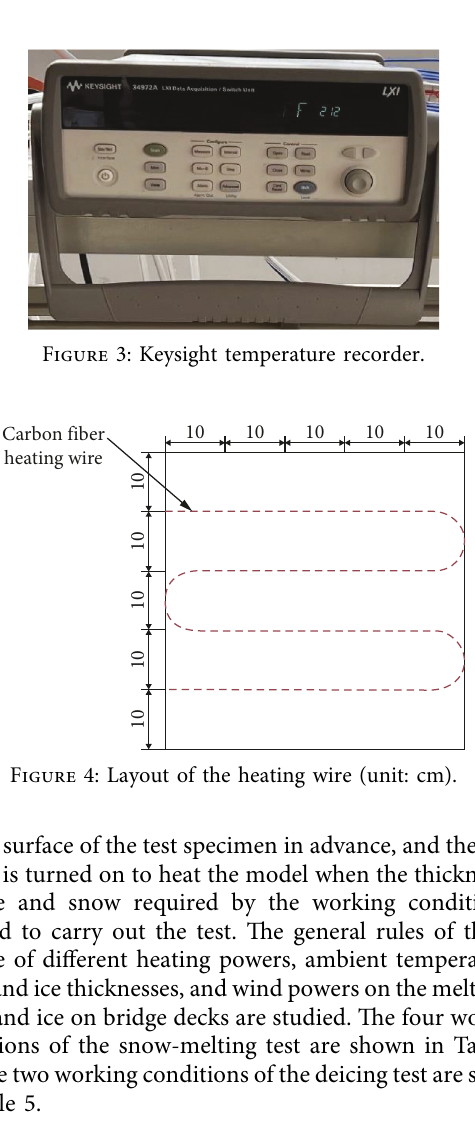
Figure 2: Cross-sectional view of an asphalt concrete specimen (cm).